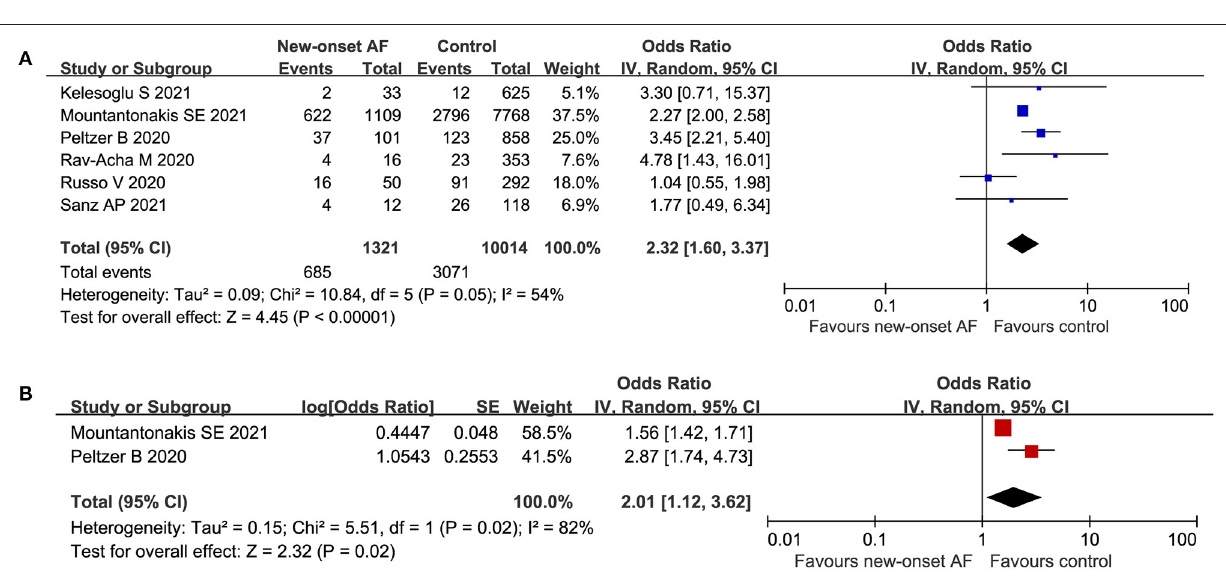
FIGURE 5 | Forest plot of the association between new-onset atrial fibrillation and all-cause mortality in patients with COVID-19. (A) Crude effect size of the association between new-onset atrial fibrillation and all-cause mortality in patients with COVID-19. (B) Adjusted effect size of the association between new-onset atrial fibrillation and all-cause mortality in patients with